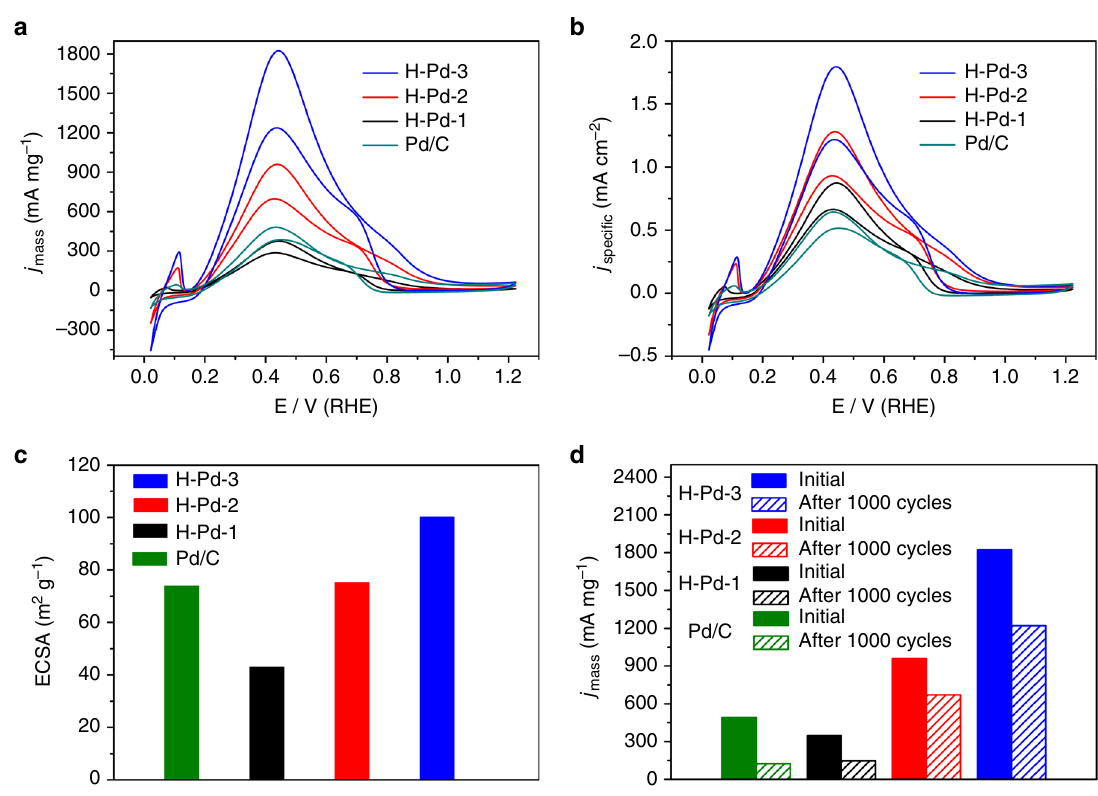
Fig. 6 Electrochemical catalytic performance of hollow Pd nanoparticles and commercial Pd/C toward formic acid oxidation. a Mass and b speci fi c activities of the catalysts. c Speci fi c electrochemically active surface areas of the catalysts. d Mass activities of the catalysts before and after the